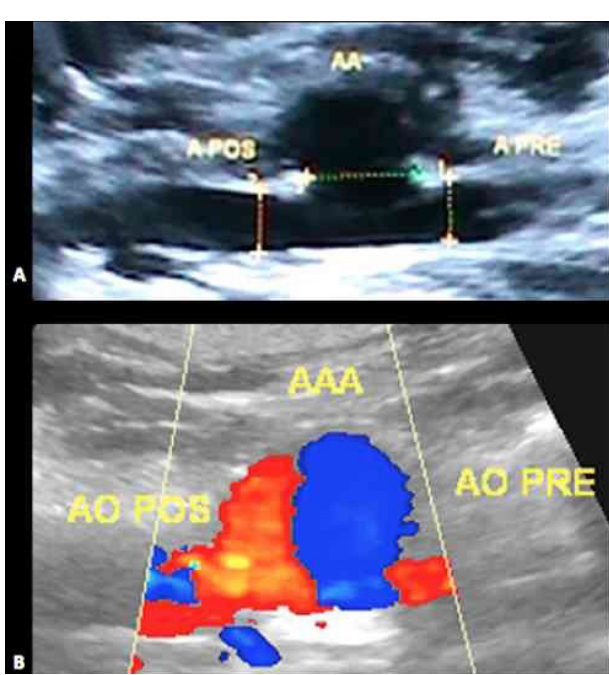
Fig. 3 – Ultrasonography B mode identifying the aneurysm (AA) and the proximal (A PRE) and distal (A POS) aorta. B – Doppler ultrasonography showing aneurysm patency.